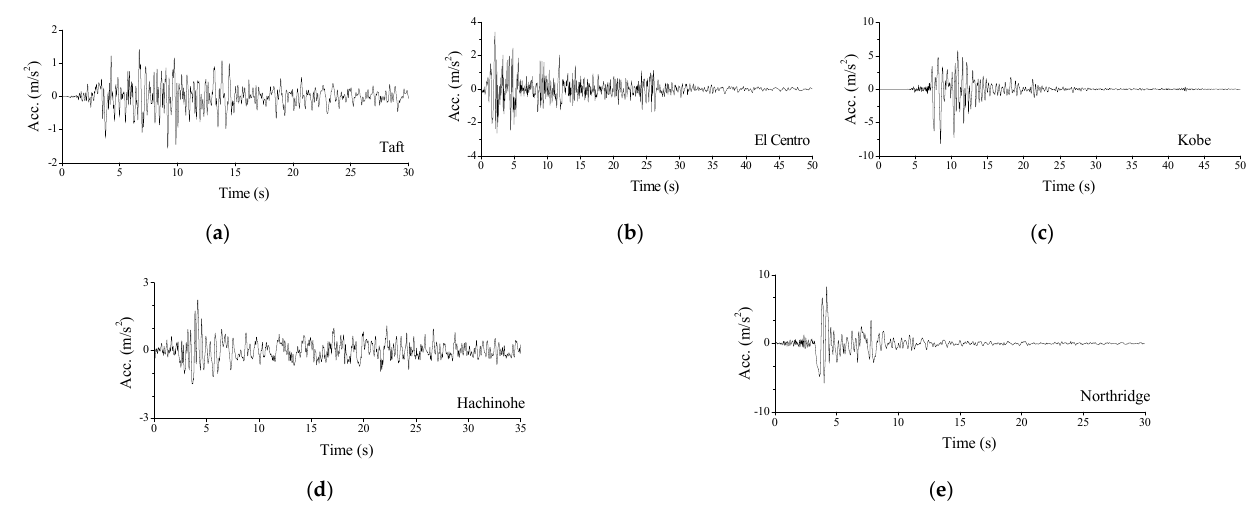
Figure 4. Time histories of four historical seismic records. ( a ) Taft; ( b ) El Centro; ( c ) Kobe; ( d ) Hachinohe; ( e ) Northridge. Table 1. Comparison of dynamic properties of the 3D and 2D models. Freq.no 3D Finite Element Model 2D Dynamic Model